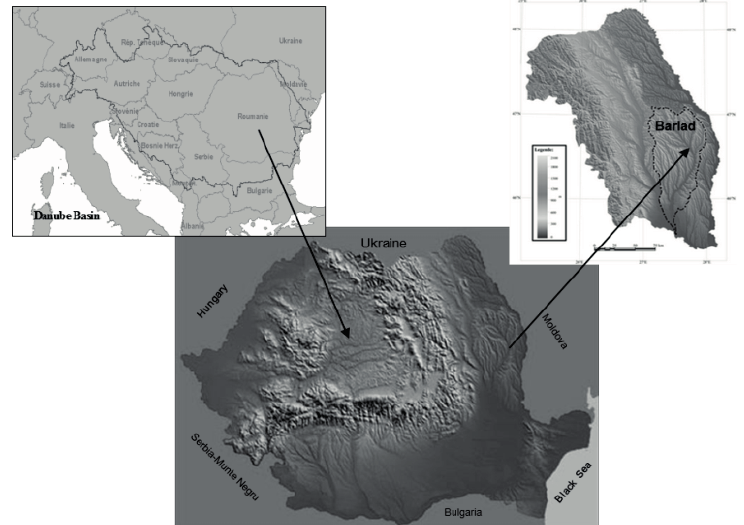
Fig. 1 Study area: Barlad River